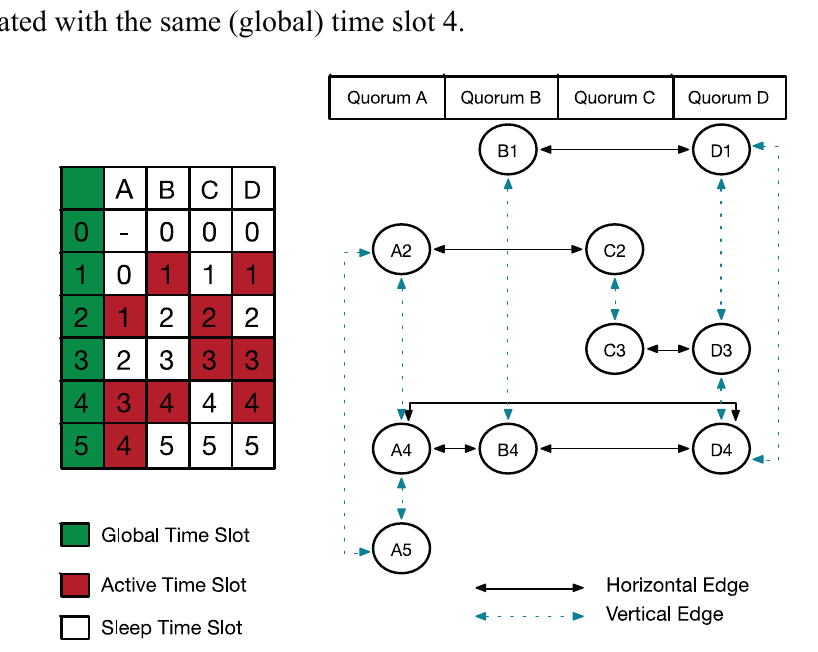
Figure 2. Example of quorum